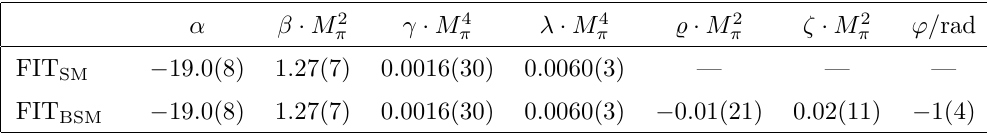
Table 5 . Results for the subtraction constants of the Standard-Model amplitude in the first row and the full C - and CP -odd dispersive representation in the second